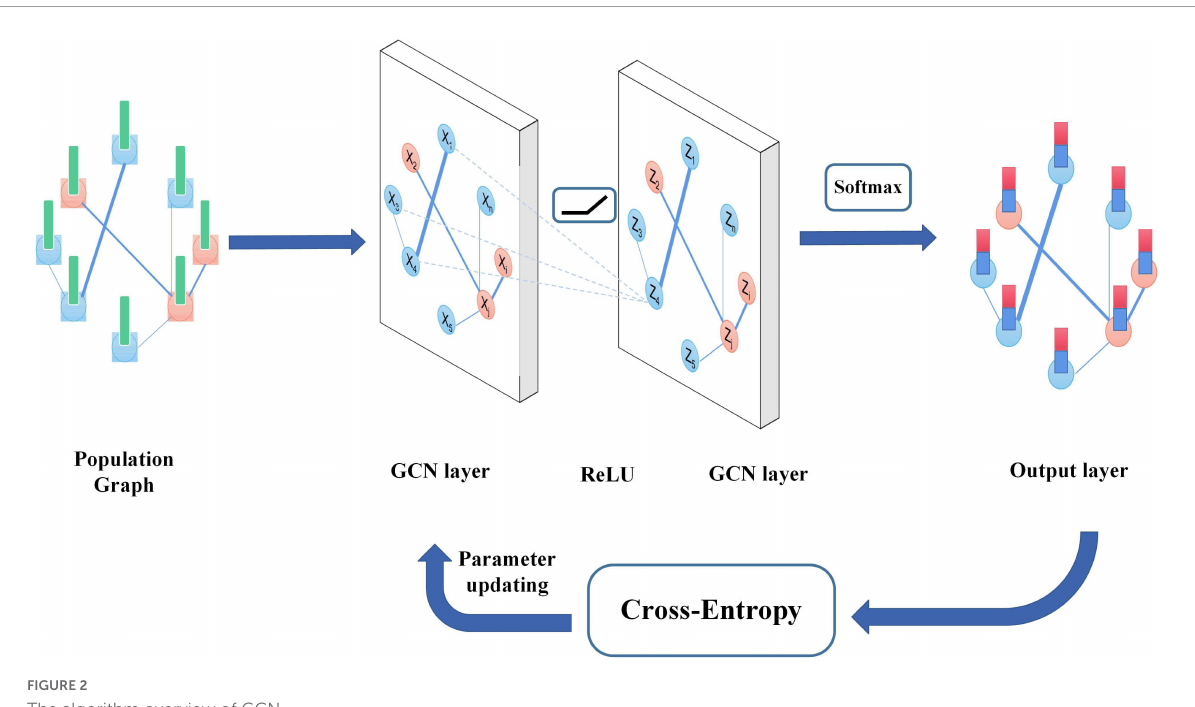
FIGURE2 The algorithm overview of